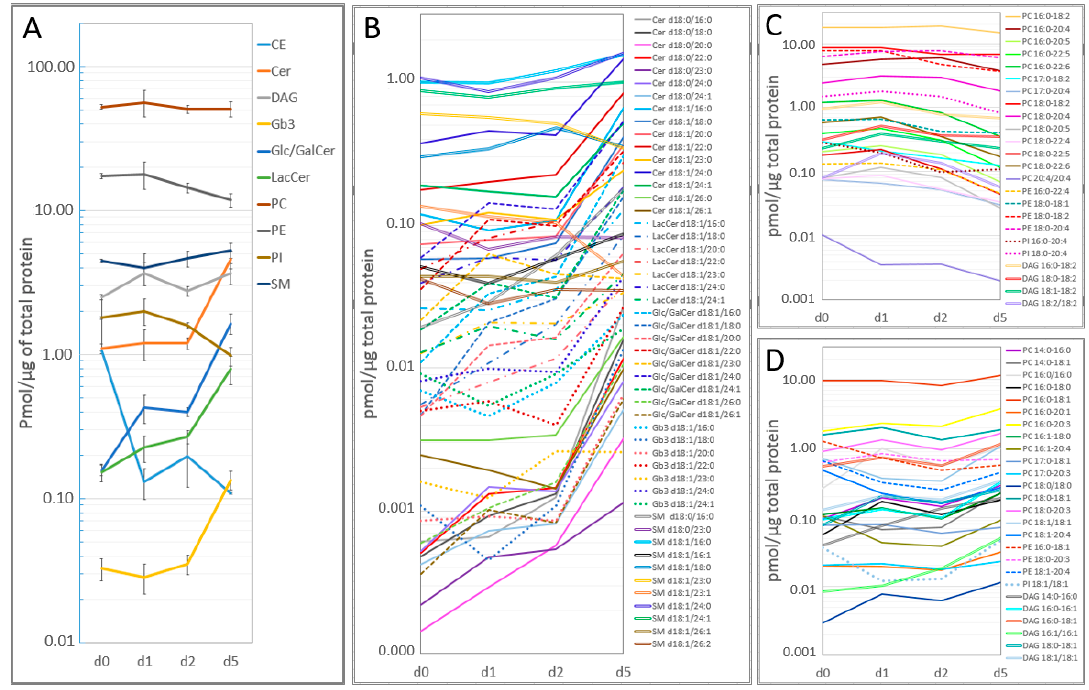
Figure 2. Alterations in the lipid profile of the PHHs during the dedifferentiation. Lines describe the detected concentration (pmol/µg total protein) of ( A ) different lipid classes, ( B ) molecular sphingolipid (SL) species, and ( C , D ) molecular phospholipid (PL) and diacylglycerol (DAG) species detected in PHHs at days 0, 1, 2, and 5; ’d’ represents days in culture. Panel C shows the PL molecular species that decreased, and panel D the species that increased during the dedifferentiation. Bars in A represent mean ± SD of three biological replicates. The detailed values of lipidomics is provided in the Table S2. CE = cholesteryl ester, Cer = ceramide, DAG = diacylglycerol, Gb3 = globotriaosylceramide, Glc/GalCer = glucosyl/galactosylceramide, LacCer = lactosylceramide, PC = phosphatidylcholine, PE = phosphatidylethanolamine, PI = phosphatidylinositol, SM = sphingomyelin.